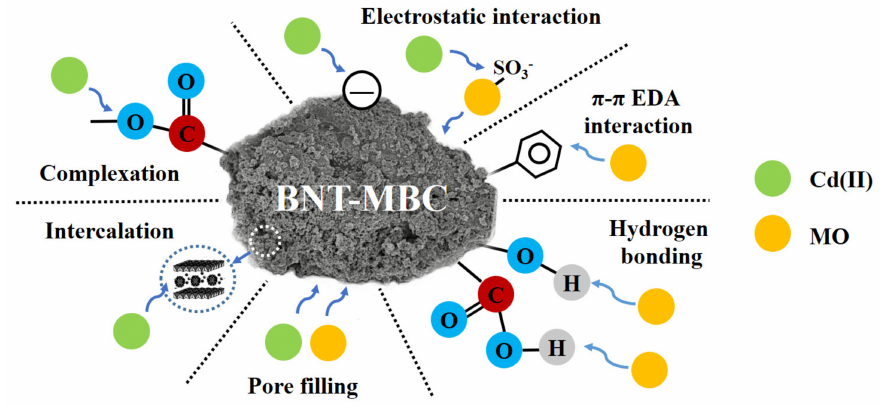
Figure 7. Hypothesis mechanism of co-adsorption of MO and Cd(II) by bentonite − biochar